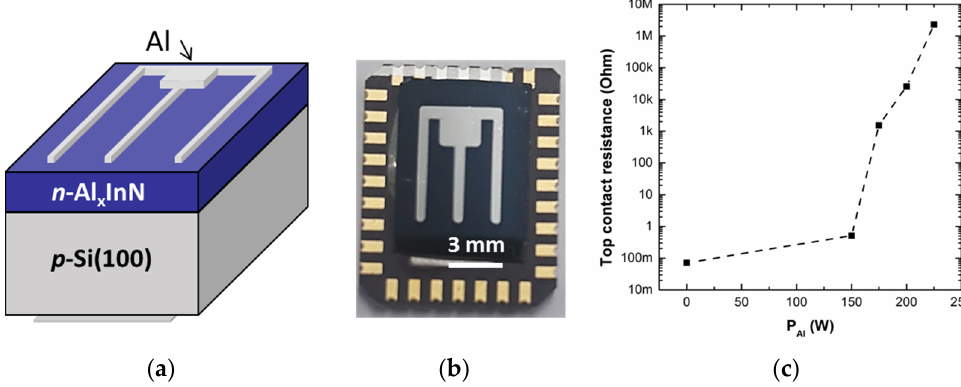
Figure 1. ( a ) Schematic description of an Al x In 1 − x N on Si hetero-junction solar cell. ( b ) Top-view image of a representative device with ~0.7 cm 2 area. ( c ) Variation of the top n-contact resistance deposited on the Al x In 1 − x N layer vs the power applied to the Al target (P Al ) used for the Al x In 1 − x N growth.